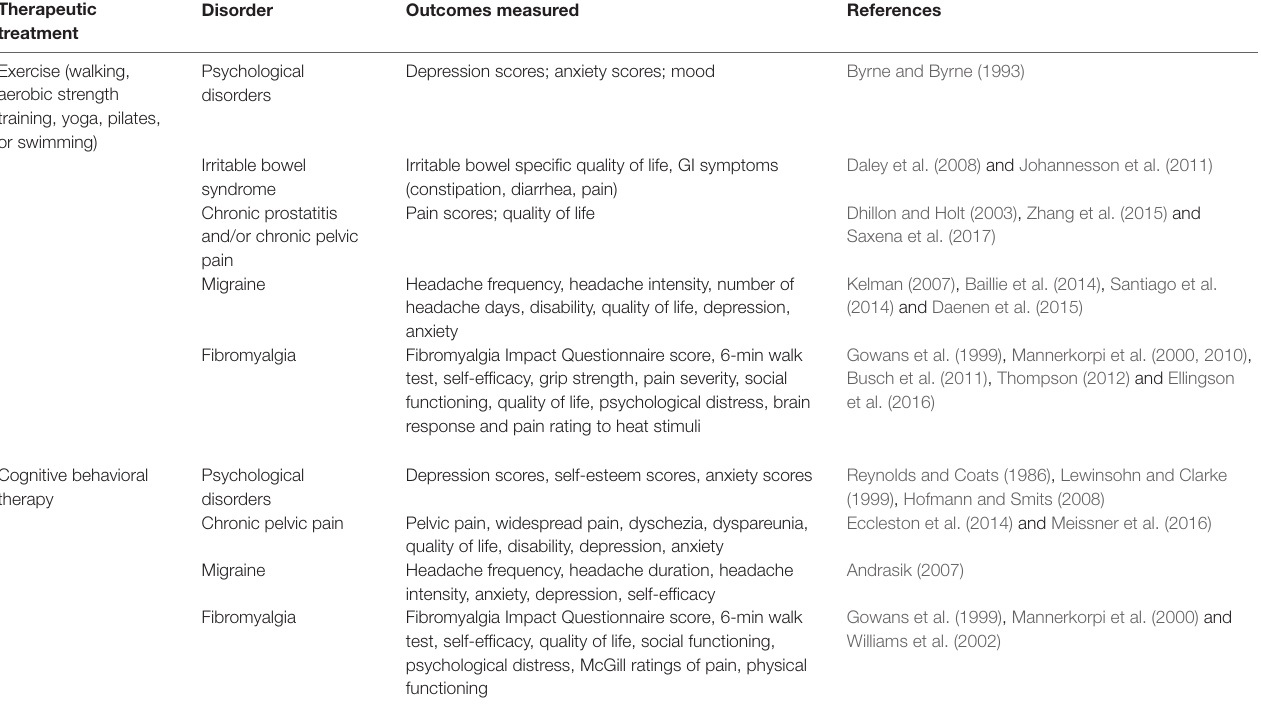
TABLE 1 | Evidence of non-pharmacological therapies for the treatment of centralized pain symptoms and associated comorbidities. Therapeutic